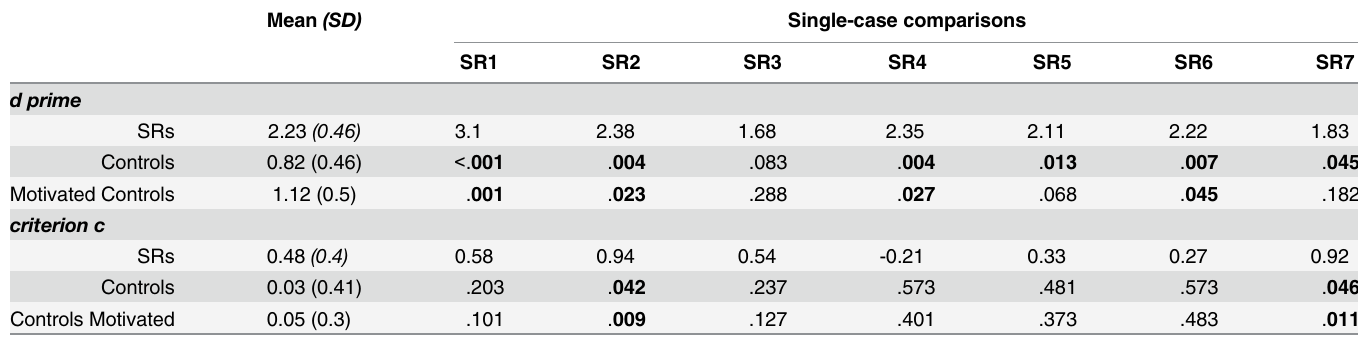
Table 5. Individual case analyses of sensitivity of SRs in MFMT using modified t-tests for single-case comparisons